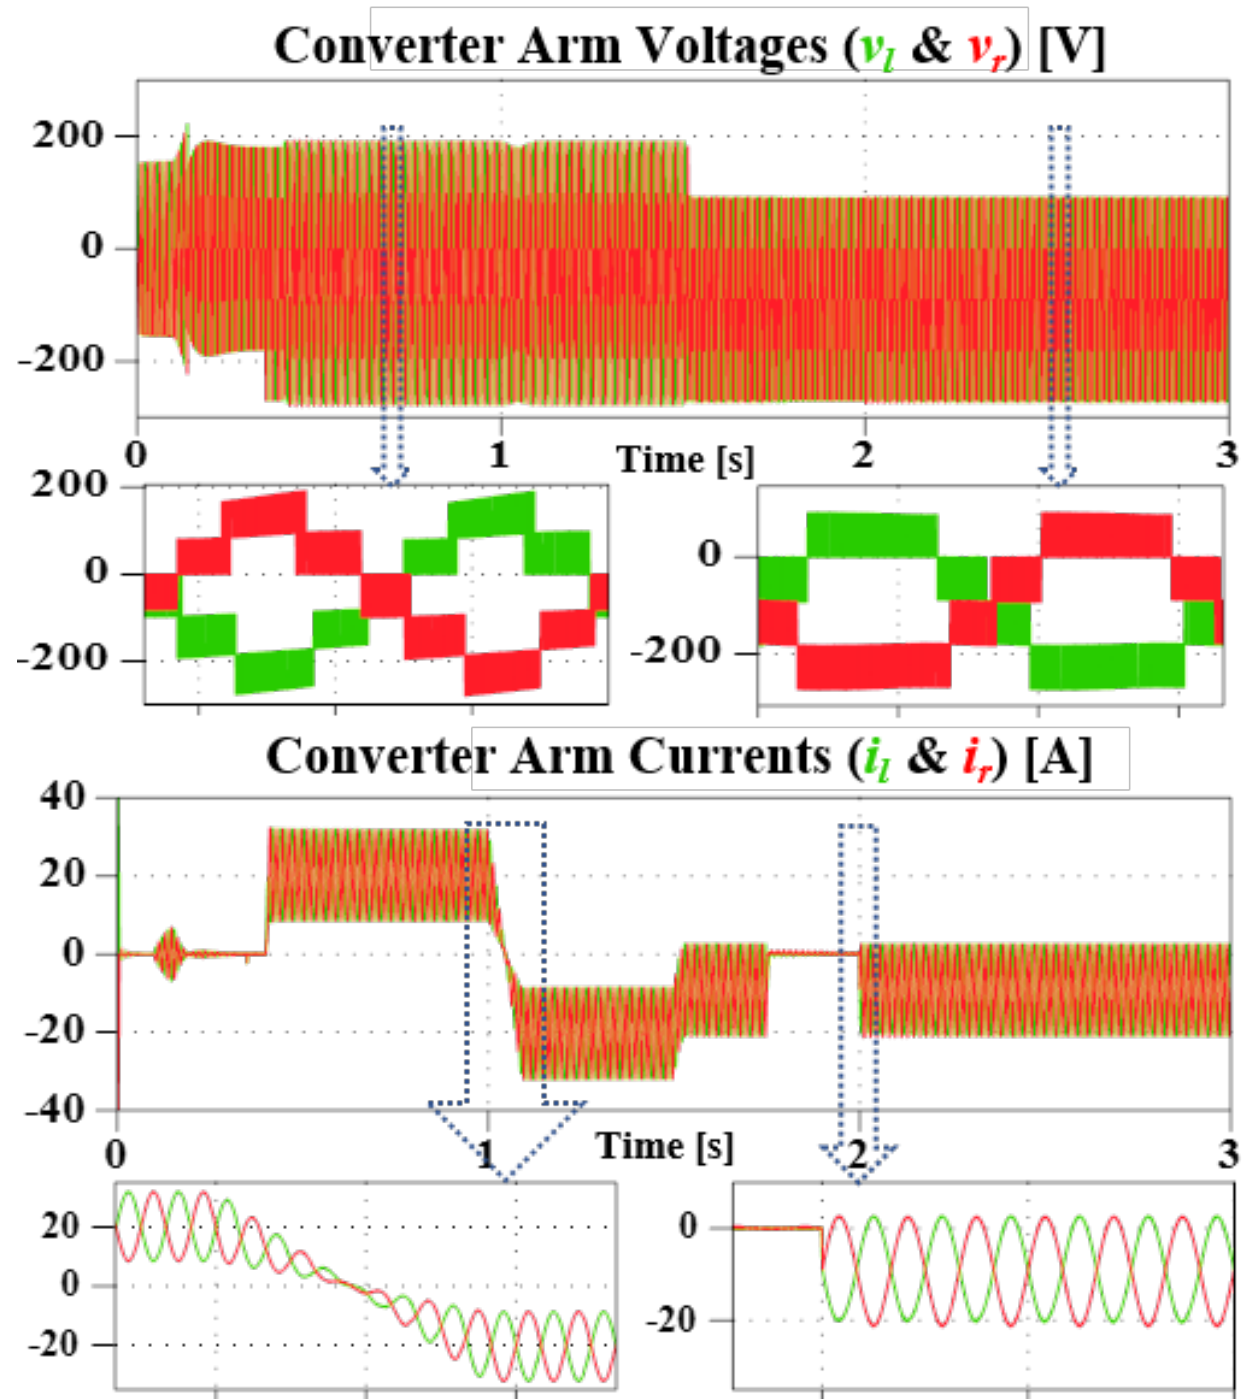
Figure 7. Simulation result of the converter arms output voltage, and output current during transients and